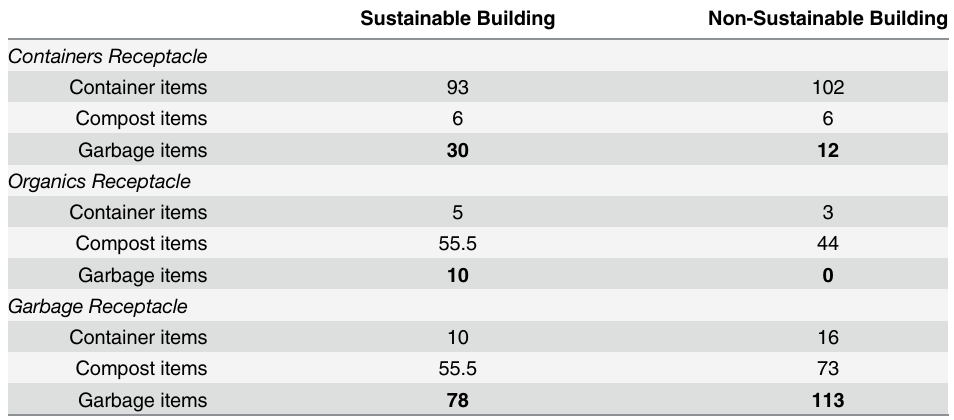
Table 2. Number of items found in each receptacle type based on building condition. Bolded numbers represent significant differences based on χ 2 tests ( p <